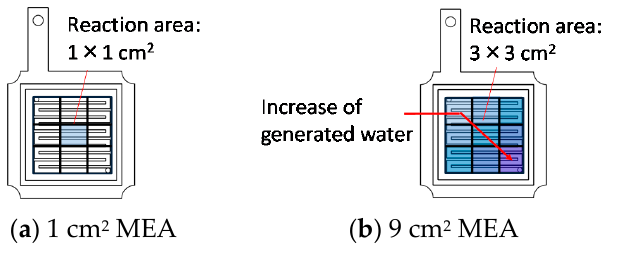
Figure 11. Schematic diagram of influence of the electrode area on drainage. 1 cm 2 MEA contacts with 0.54 cm 2 gas channel ( a ), and 9 cm 2 MEA contacts with 6.12 cm 2 gas channel ( b ).